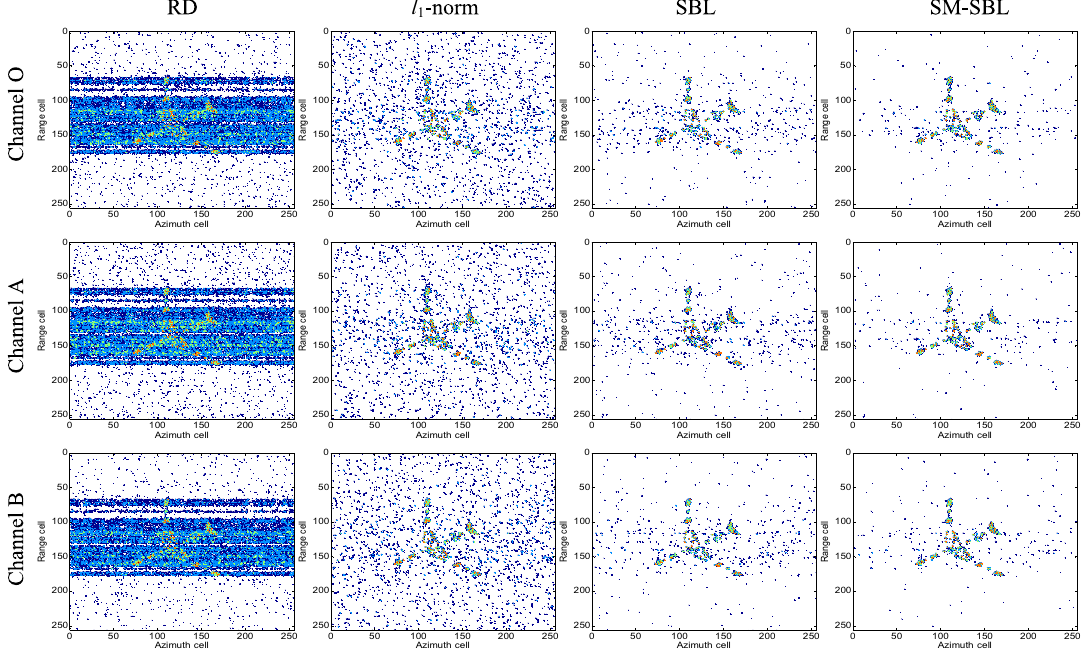
Figure 5. Inverse synthetic aperture radar (ISAR) imagery results for random missing sampling